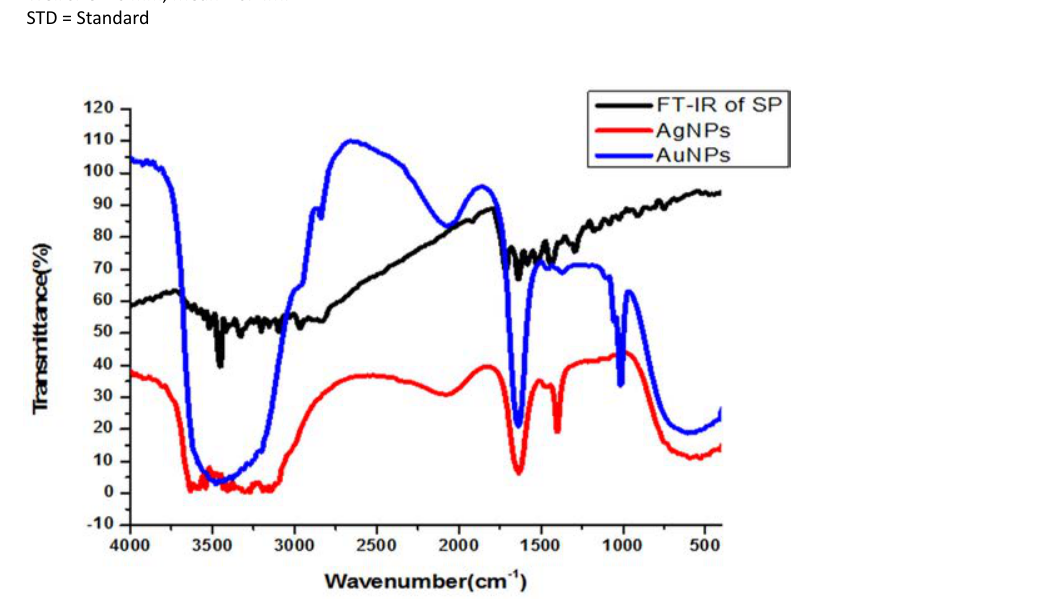
Fig. 5. FTIR spectra of sparfloxacin and its silver and gold NPs